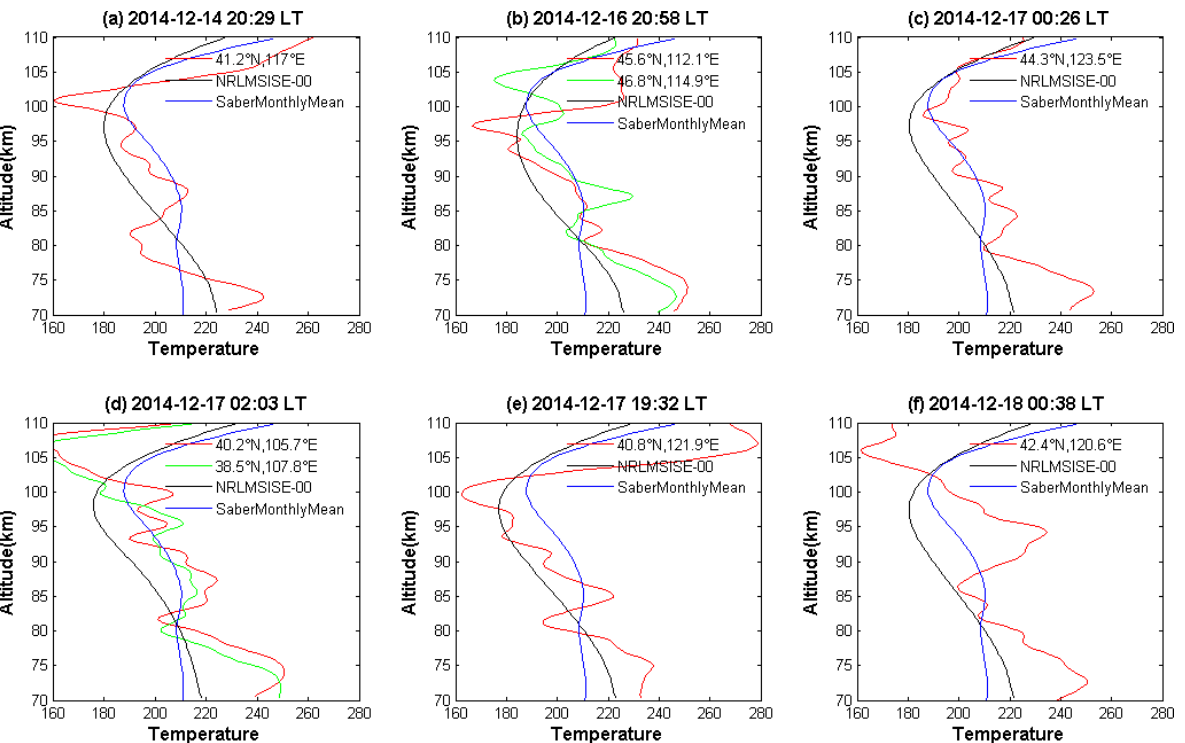
Figure 11. SABER temperature profiles obtained near the lidar location. Blue and black lines in each subplot represent the temperature profiles from the empirical atmospheric model NRLMSISE-00 (Naval Research Laboratory Mass Spectrometer and Incoherent Scatter Radar Exosphere 2000) and monthly average SABER results near the lidar location,